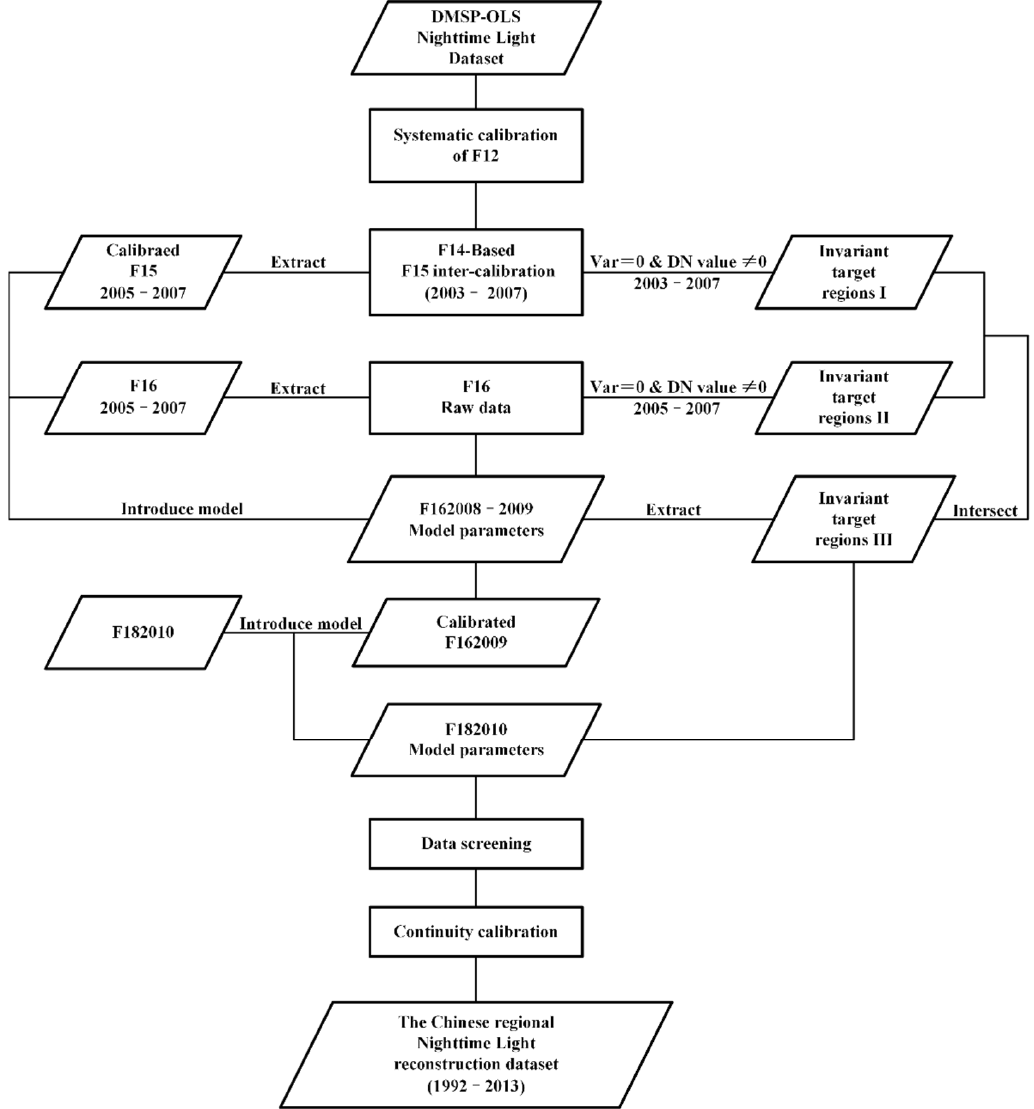
Figure 2. The flowchart of the improved stepwise calibration (ISC) method.